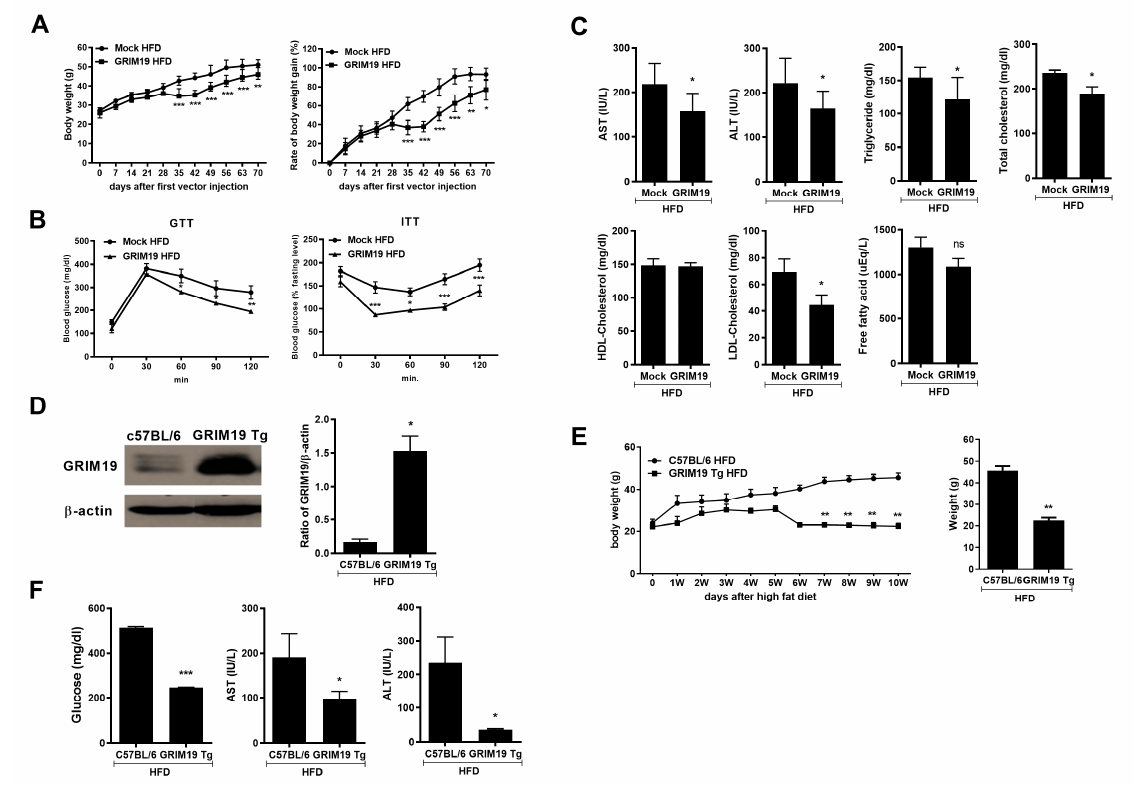
Figure 3. Overexpression of GRIM19 by two different strategies leads to the attenuation of high-fat diet (HFD)-induced obesity. ( A ) Kinetics of body weight changes (left) and rates of body weight gain (right) in HFD-fed control and GRIM19- administered mice over three independent experiments. ( B ) Glucose tolerance test (GTT, left) and insulin tolerance test (ITT, right) results for HFD-fed control and GRIM19-administered mice ( n = 5). ( C ) Measurements of serum aspartate aminotrans- ferase (AST), alanine aminotransferase (ALT), triglycerides, total cholesterol, high-density lipoprotein (HDL)-cholesterol, low-density lipoprotein (LDL)-cholesterol, and free fatty acid levels in HFD-fed control and GRIM19-administered mice ( n = 5). ( D ) Splenocytes were obtained from wild-type (WT) and GRIM19-Tg mice. Cells were prepared to examine the expression of GRIM19. The bar graph shows relative intensity. ( E ) Kinetics of body weight changes in HFD-fed control and GRIM19-Tg mice. The bar graph shows the averaged body weights of HFD-fed WT and GRIM19-Tg mice at 10 weeks ( n = 5–7). ( F ) Measurements of glucose, AST, and ALT levels in serum in HFD-fed control and GRIM19-Tg mice ( n = 5–7). Data are presented as the means ± SDs. * p < 0.05, ** p < 0.01, *** p < 0.001, ns = not significant.